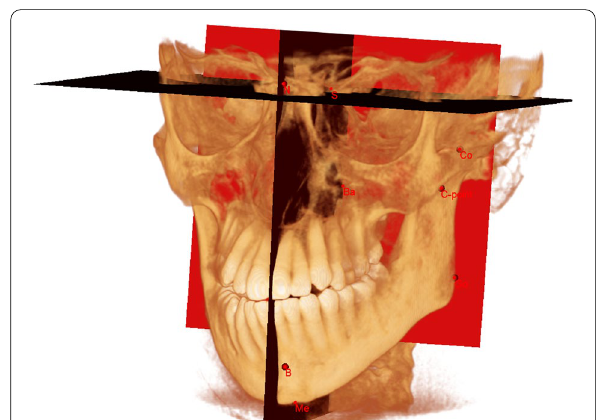
Fig. 3 Software view of the cephalometric reference system used in the present